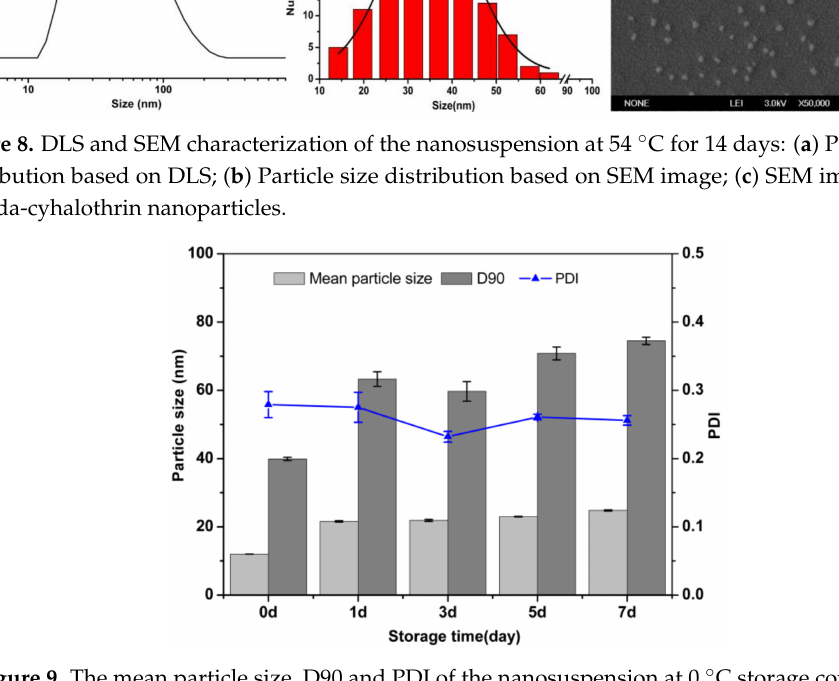
Figure 9. The mean particle size, D90 and PDI of the nanosuspension at 0 ◦ C storage condition.